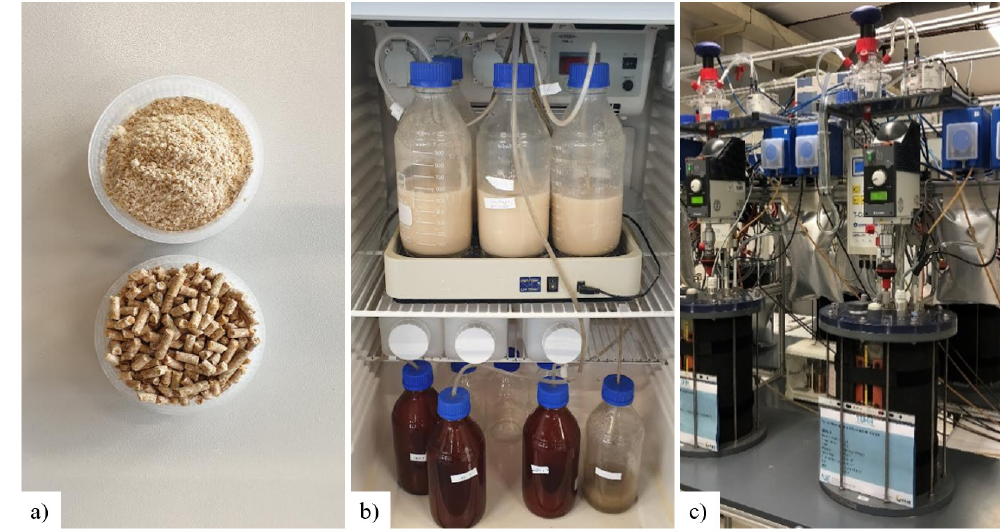
Figure 2. ( a ) Original and grinded pellets; ( b ) feeding and discharging bottles in the fridge; ( c ) CSTR reactors.